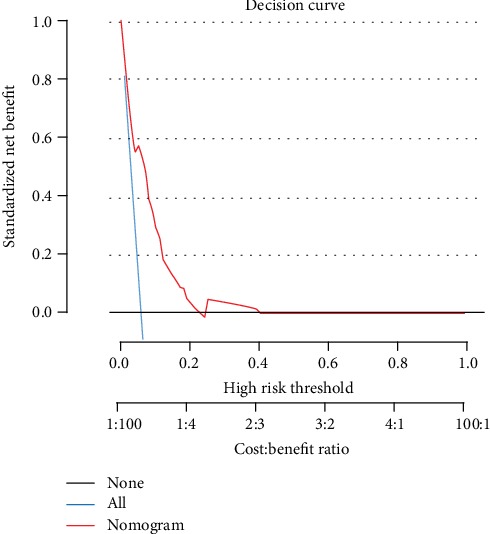
Decision curve analysis for the nomogram. The y-axis measures the net benefit. The red line represents the nomogram. The blue line represents the treat-all scheme, and the black line represents the treat-none.